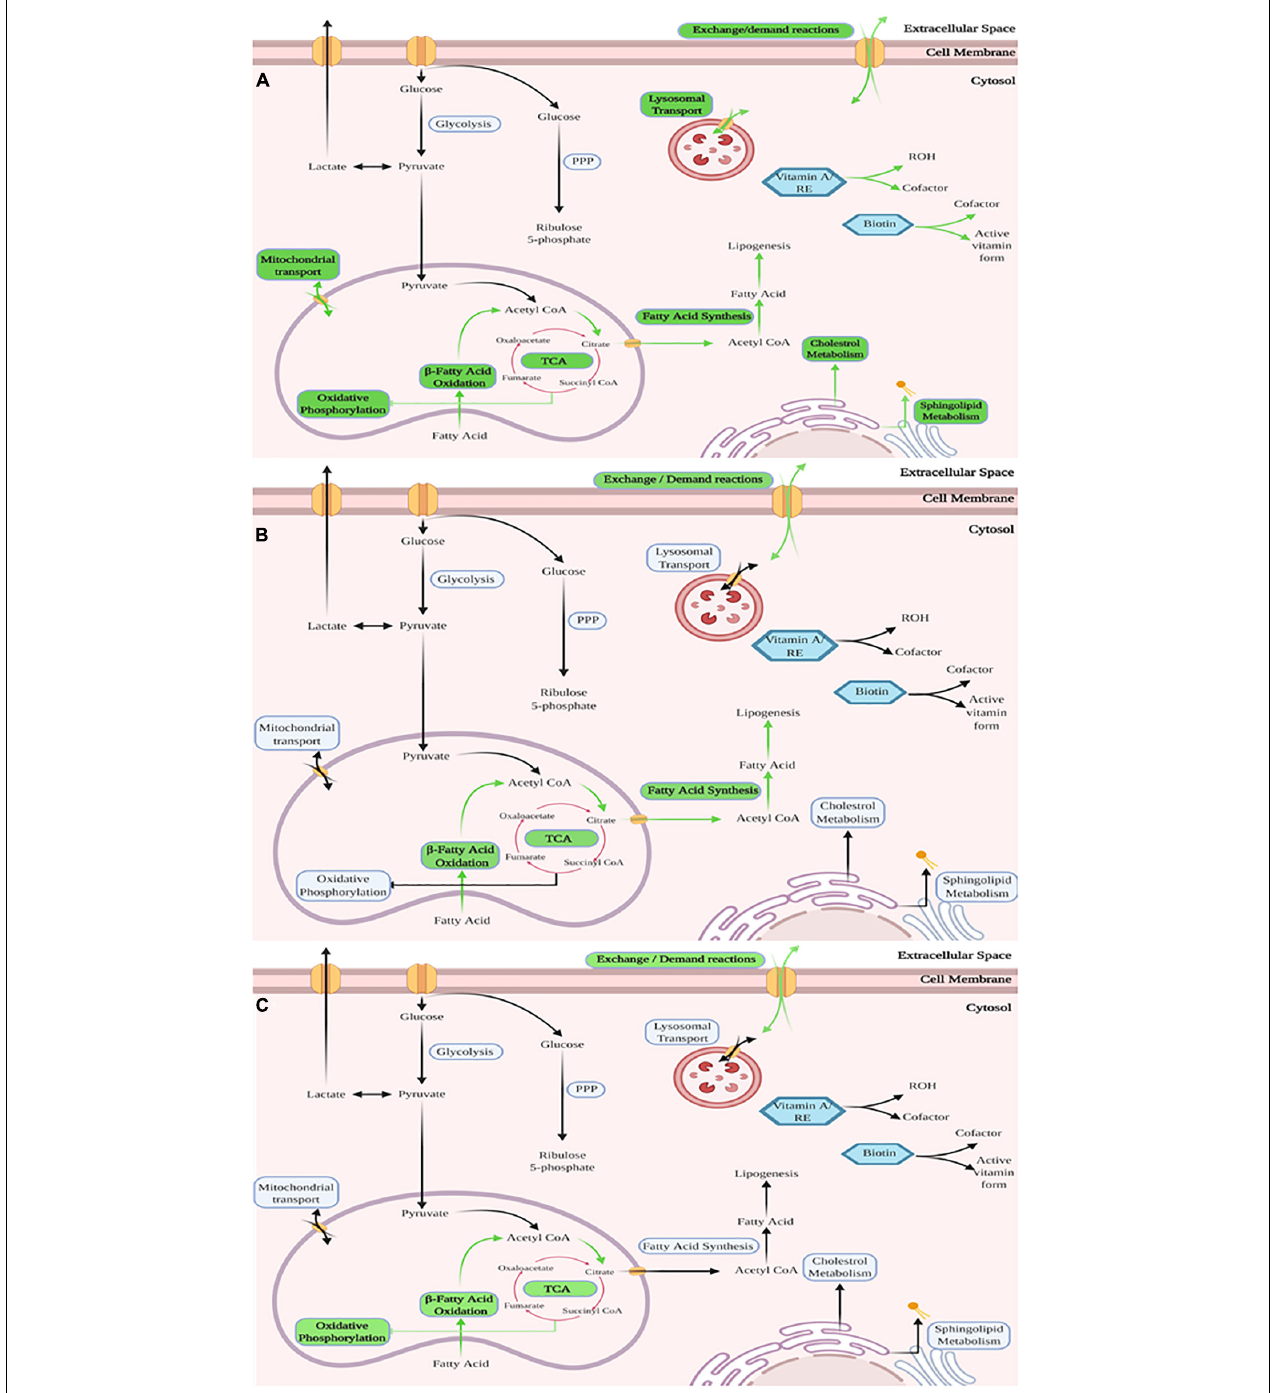
FIGURE 5 | Graphical representation of the enriched subsystems between the cell lineages based on the new reconstructed models – The three figures show in a graphical manner the subsystems (a group of related metabolic reactions representing a specific aspect of metabolism) in each model that were found to contain significantly more changed reactions than other subsystems of the model. Shown is – (A) Proliferation of MSCs, with various subsystems identified as enriched. This mirrors expectations as expansion requires energy and synthesis of new material (e.g., cell wall and DNA). (B) Adipogenesis of MSCs, with subsystems related to synthesis and breakdown of fatty acids identified as enriched as well as exchange/demand reactions (C) Osteogenesis of MSCs, with subsystems related to fatty acid breakdown and TCA-cycle activity identified as enriched as well as exchange/demand reactions. For detailed list with included p -Values for each listed subsystem see Table 3 . Green arrows and labels indicate enriched